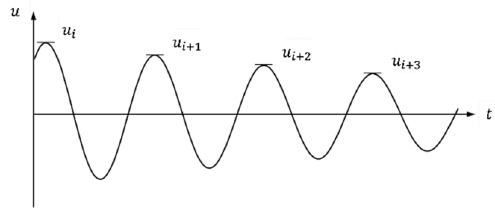
( f ) Figure 7. Time history curve of the SDOF model by free vibration test: ( a ) first test; ( b ) second test; ( c ) third test; ( d ) fourth test; ( e ) five test; ( f ) overlapping entire tests. ( a ) ( f ) Figure 8. Time history curve of the small-scale model by free vibration test: ( a ) first test; ( b ) second